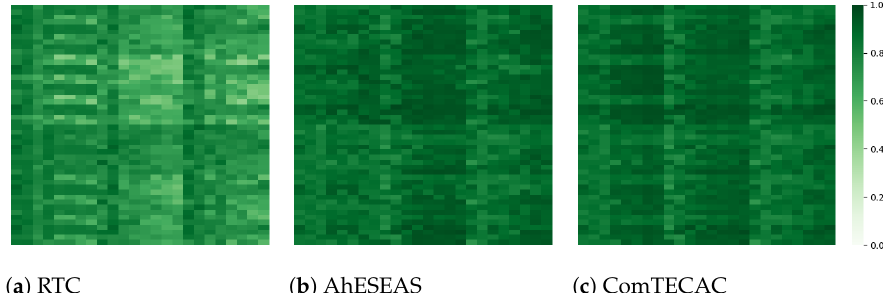
Figure 8. Older clusters’ fairness (dark is better).